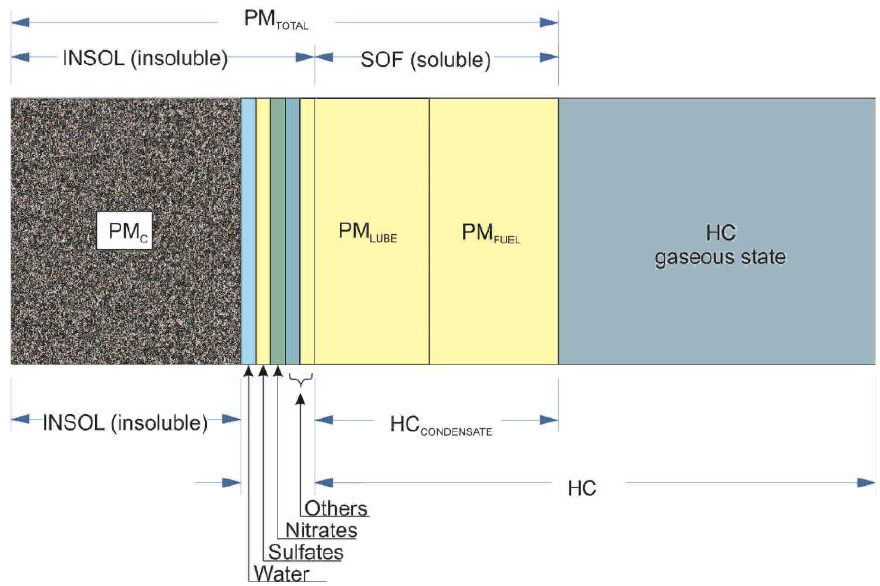
Figure 1. Diagram of the structure of a solid particle.